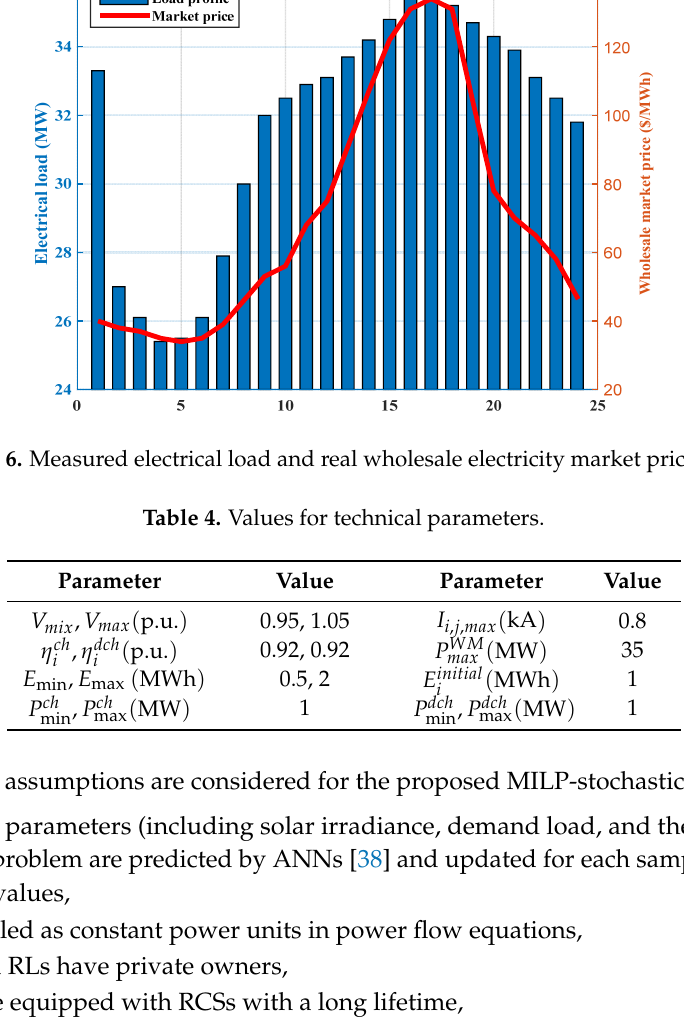
95 Table 2. Supported areas of Demand Response Providers (DRPs) in the distribution system. DRP